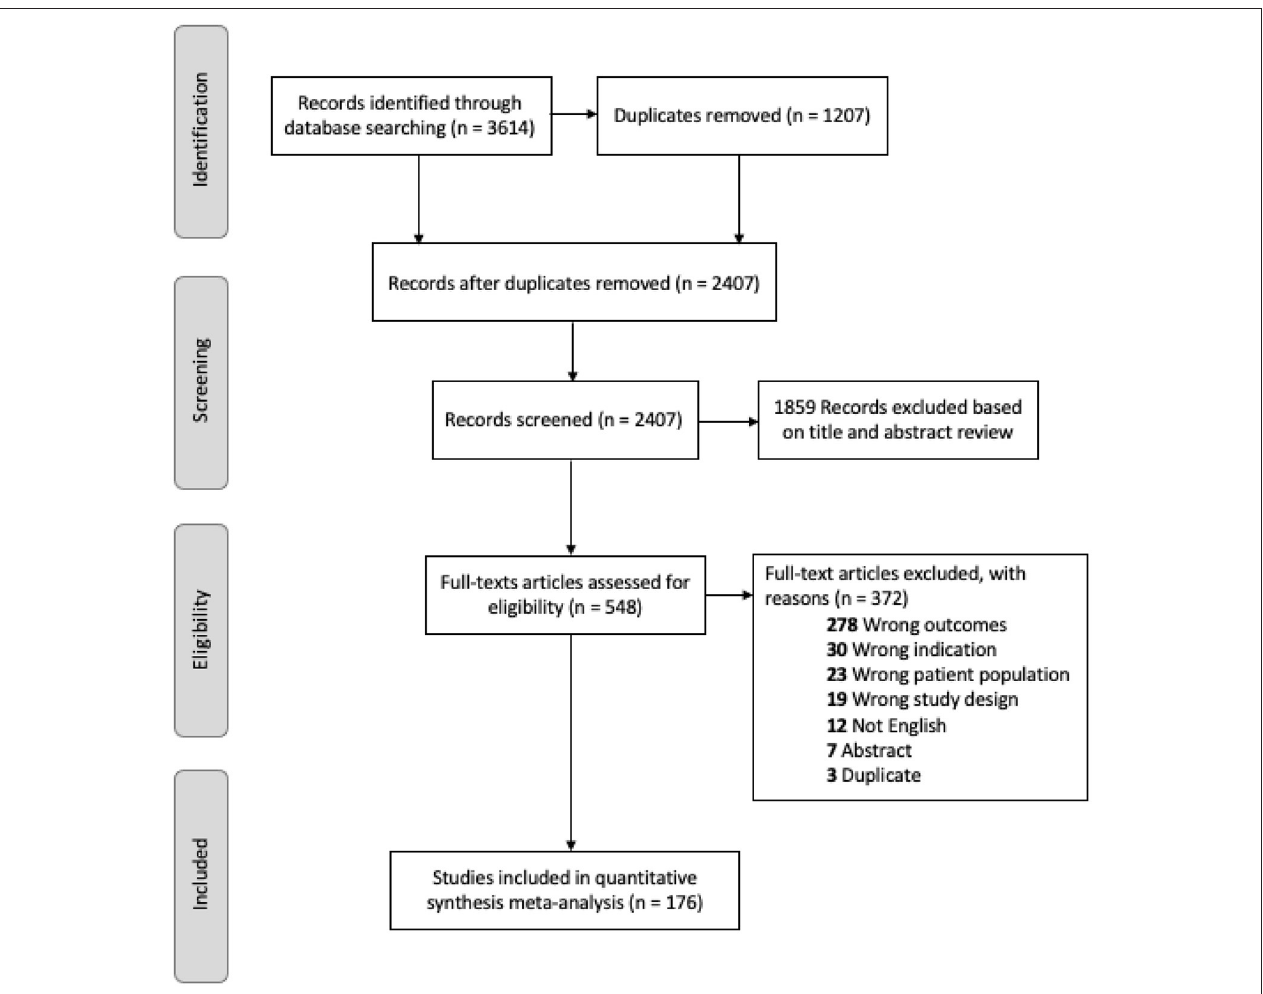
FIGURE 1 | PRISMA diagram of review search